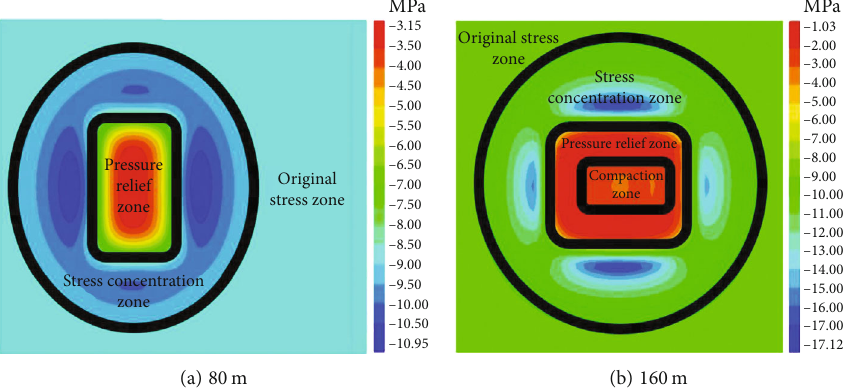
Figure 6: Distributions of vertical stress along bedding plane of protected layer at varying advancing distances.